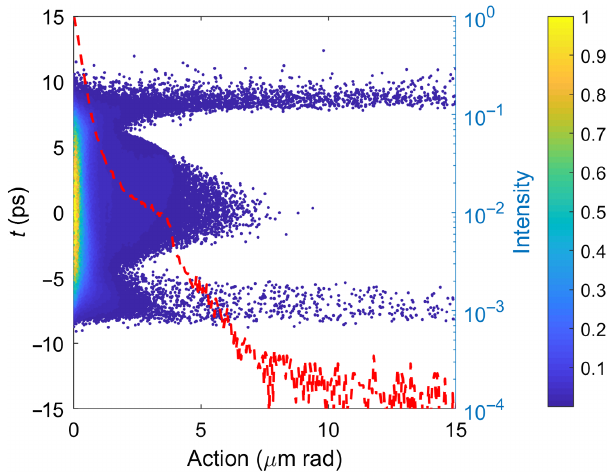
FIG. 11. Time vs action for 250 pC beam with a 7 ps Gaussian laser from ASTRA